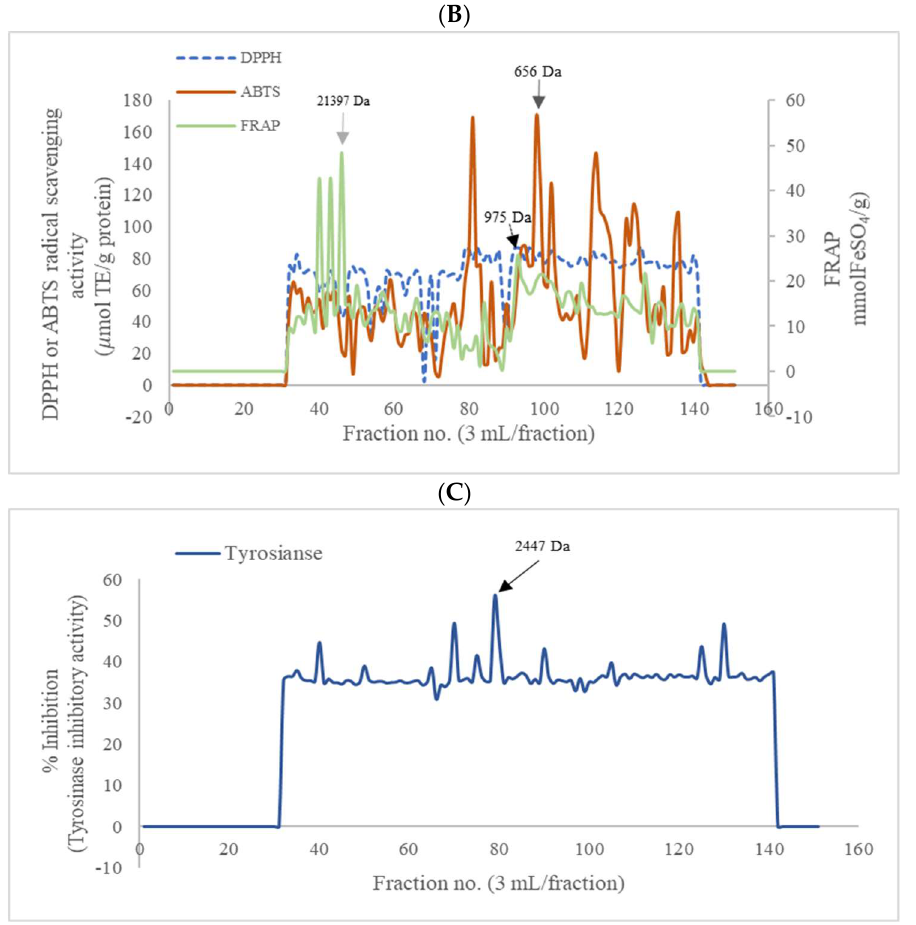
Figure 5. Elution profile of antioxidant and tyrosinase inhibitory peptide from fraction-III (MW 1–3 kDa) from JFFH using Sephadex G-25 gel filtration chromatography monitored at A 220 and A 280 ( A ). DPPH and ABTS radical scavenging and FRAP value ( B ) and tyrosinase inhibitory activity ( C ) of the different fractions.